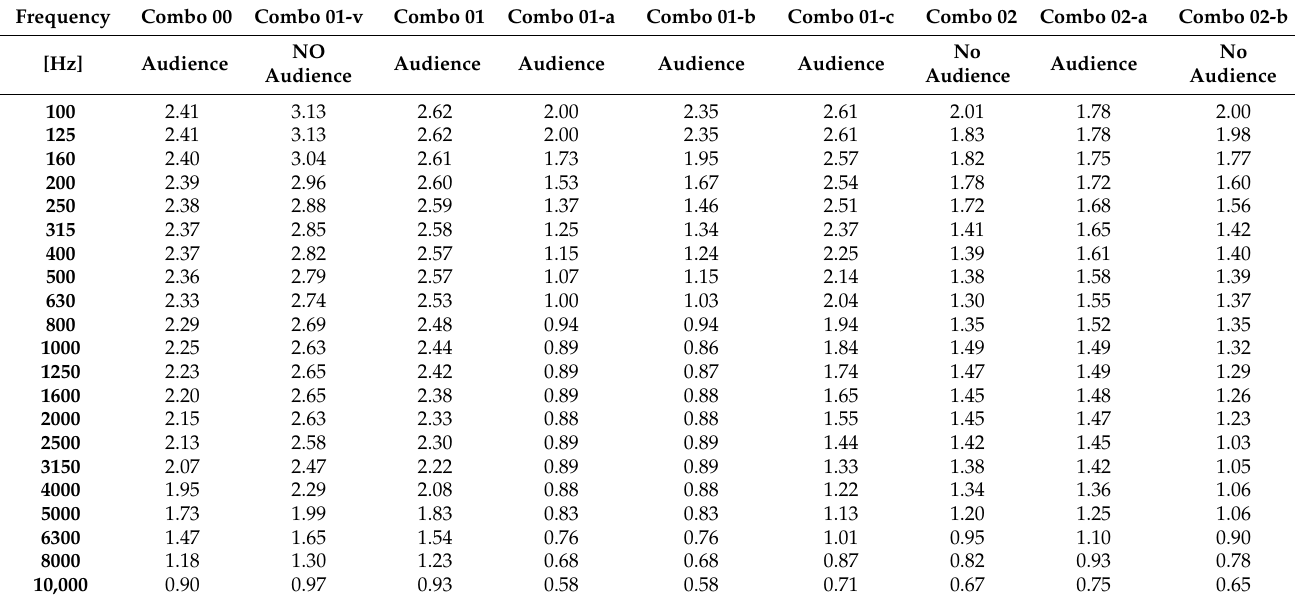
Table 14. Reverberation time T 20 according to the intended use of the